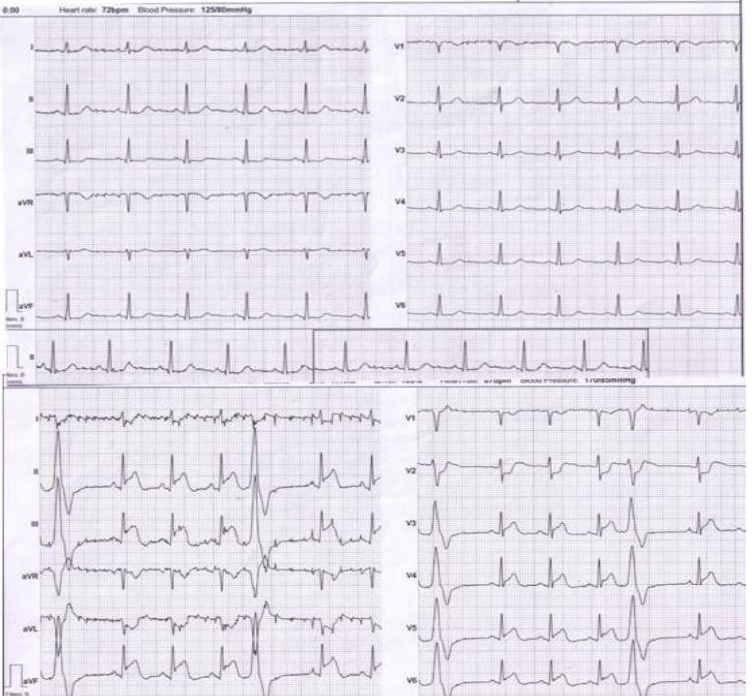
Figure 1. Results of resting 12-lead electrocardiogram showing the absence of ST-T changes (a); ST-segment elevation in V5, V6, and inferior leads with concomitant reciprocal changes in leads I, aVL, V1, and V2 with frequent premature ventricular complexes during dobutamine infusion period of 30 mcg/min (b)